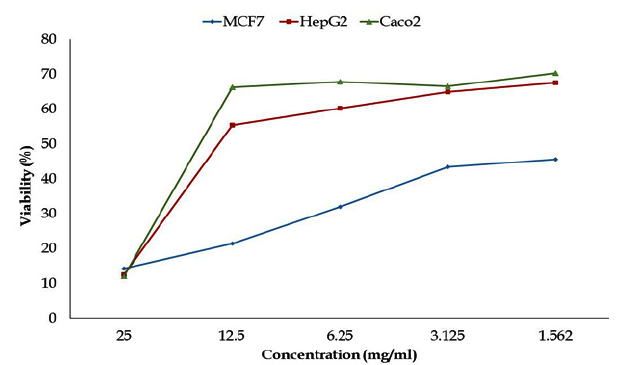
Fig. 9. Anticancer activity for different concentrations of silver nanoparticles produced by Pseudomonas sp . H64 against different cancer cell lines (measured by MTT assays after 24 h exposure)